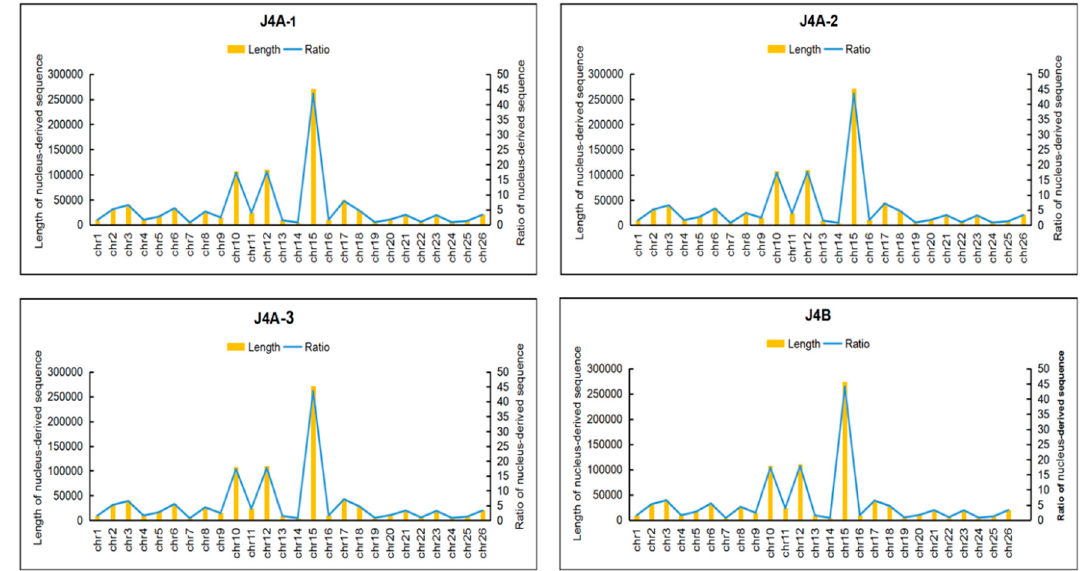
Figure 3. Distribution of nucleus-derived sequences on the chromosome. Note: The X axis shows the chromosomes of cotton. The Y axis shows the lengths of nucleus-derived sequences.